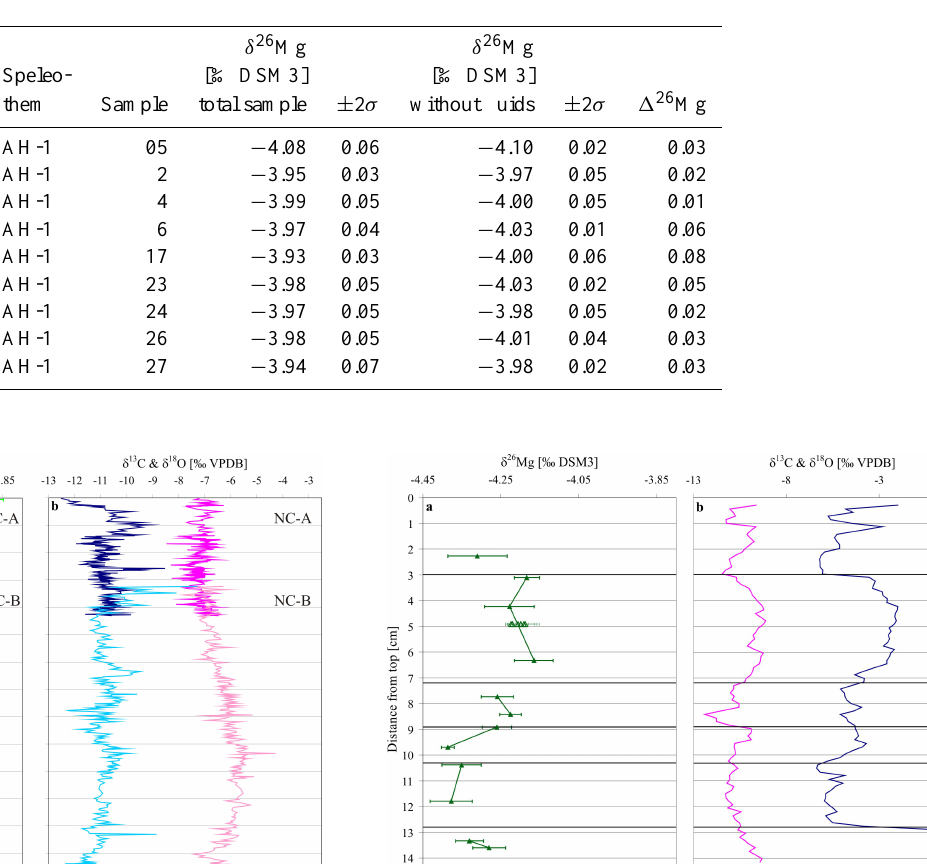
Table 4. Magnesium isotope composition of several samples of the stalagmite AH-1 measured with and without fluid inclusions and the calculated 1 26 Mg between these samples.